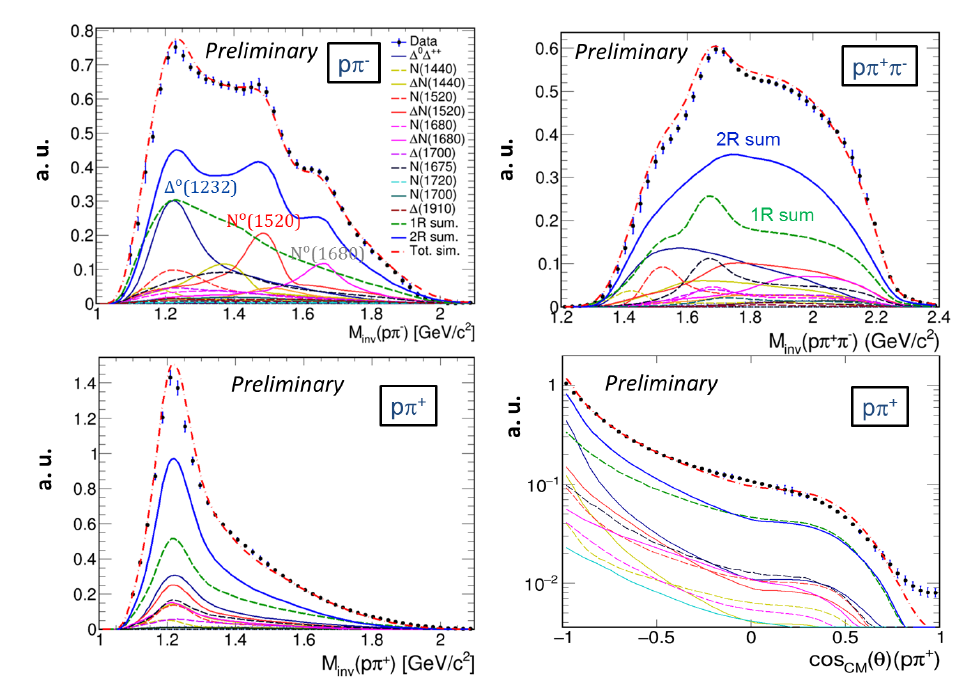
Figure 3. p π − (top left), p π + π − (top right), p π + (bottom left) invariant masses and distribution of the center-of-mass angle of the p π + system. Data (black dots) are compared to the results of the fit with the resonance model (dashed red). The total double (blue) and single (dashed green) contributions are shown together with the most important individual contributions (see color code on the picture).